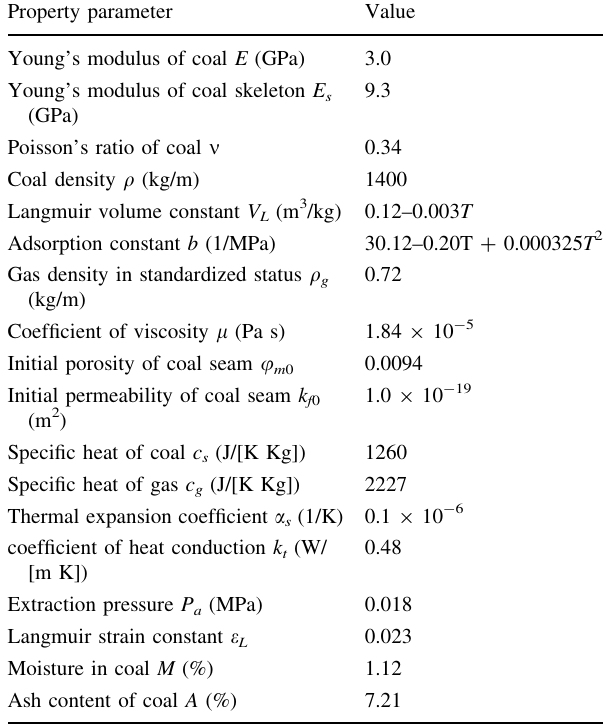
Table 1 Property parameters in the numerical model Property